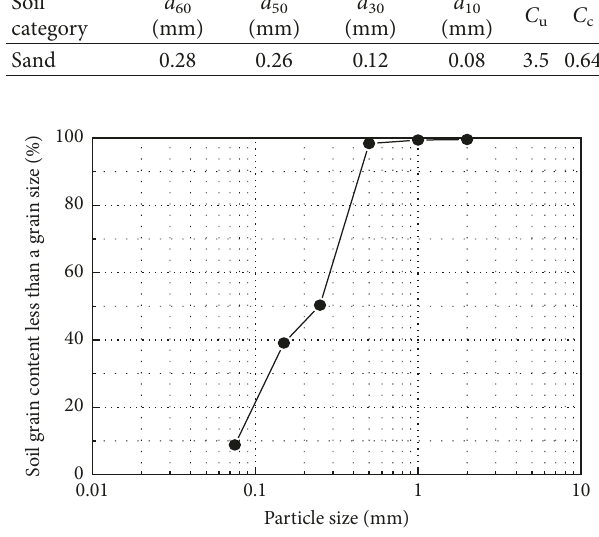
Figure 1: Sand particle sieving